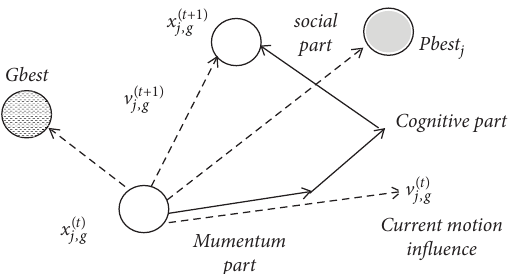
Figure 10: Adjustment of position and velocity of particles in the PSO algorithm.